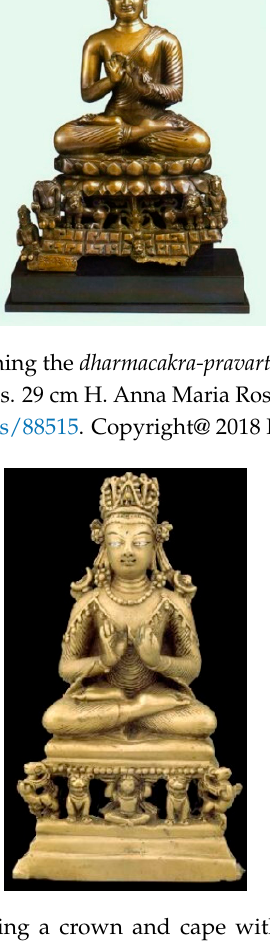
Figure 37. Vairocana Buddha wearing a crown and cape with crescent moon and sun symbols performing the dharmacakra-pravartana mudr ā , seventh c. Kashmir. Brass with silver inlay. Private collection.